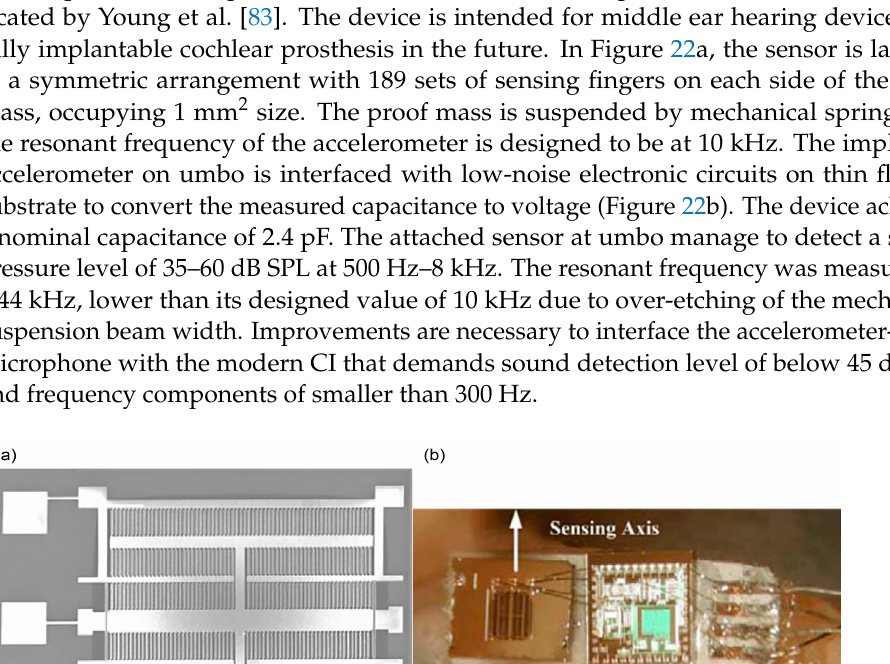
Figure 22. ( a ) The micrograph image of the fabricated capacitive accelerometer-based microphone. ( b ) The accelerometer is interfaced with the low-noise differential capacitance-to-voltage conversion circuitry and then implanted onto umbo. © 2012 IEEE. Reprinted, with permission, from